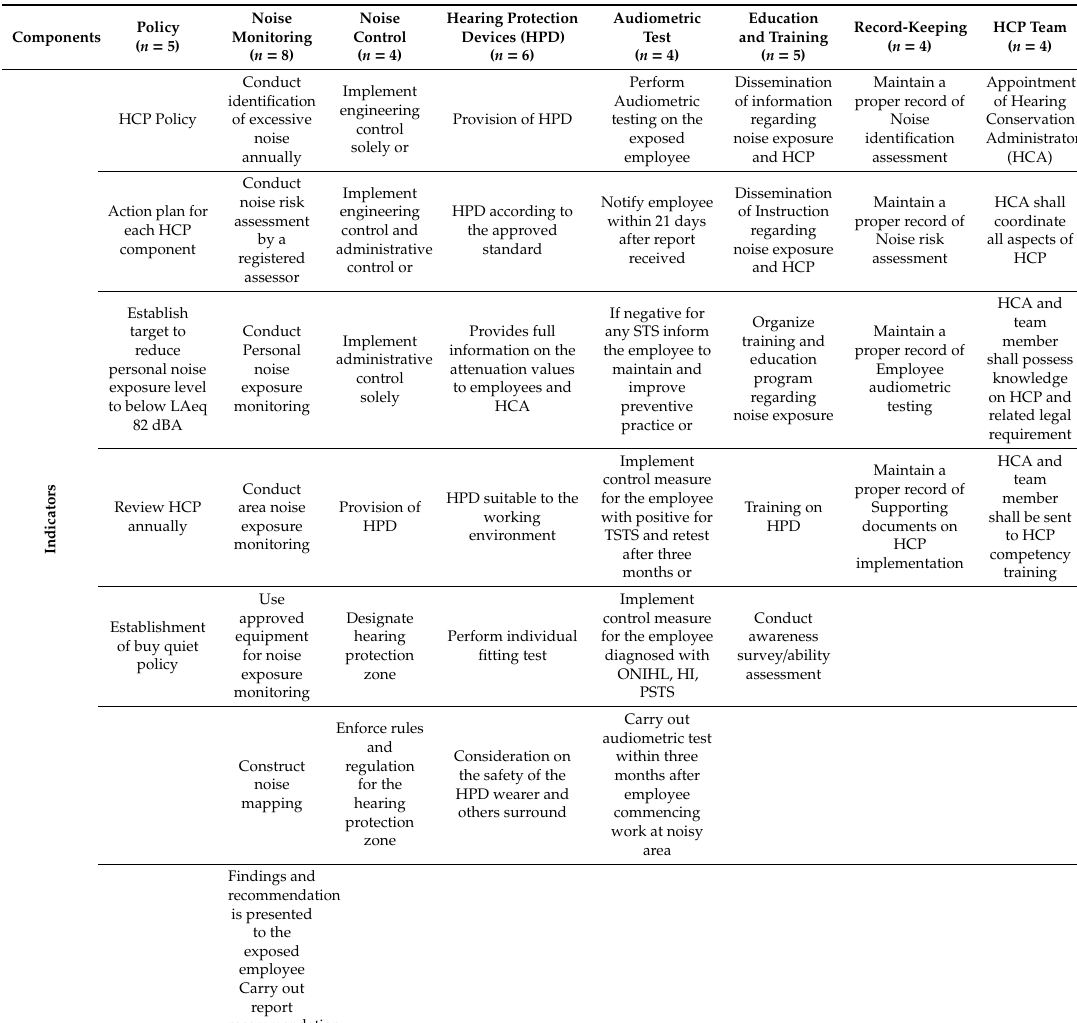
Table 1. Compliance indicators for each hearing conservation program (HCP) component.